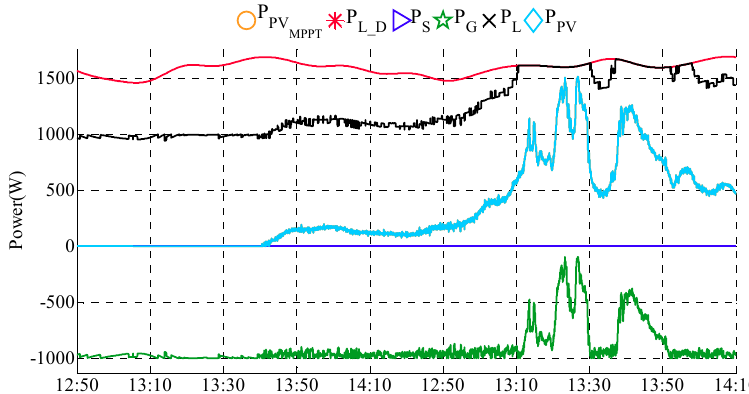
Figure 10. Load shed detail.